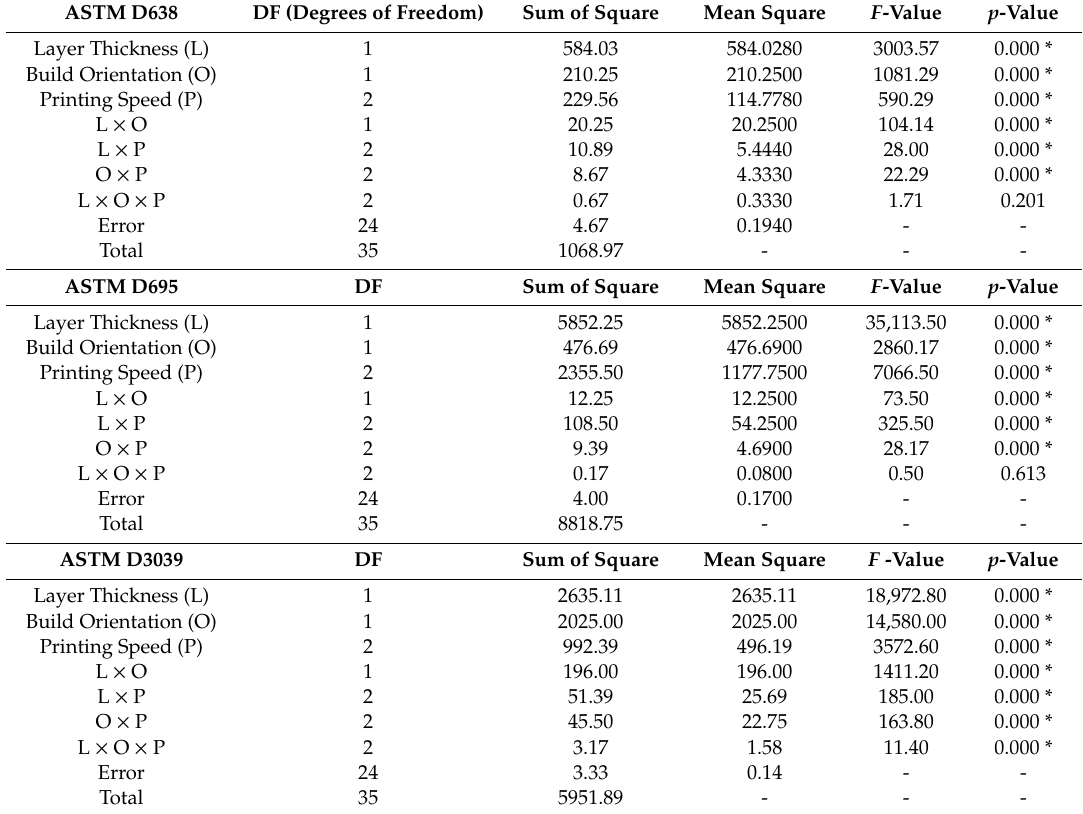
Table 6. ANOVA results for the printing time (* α <